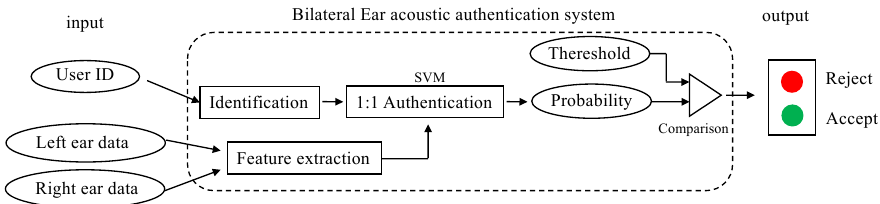
Figure 5. Overview of bilateral ear acoustic authentication